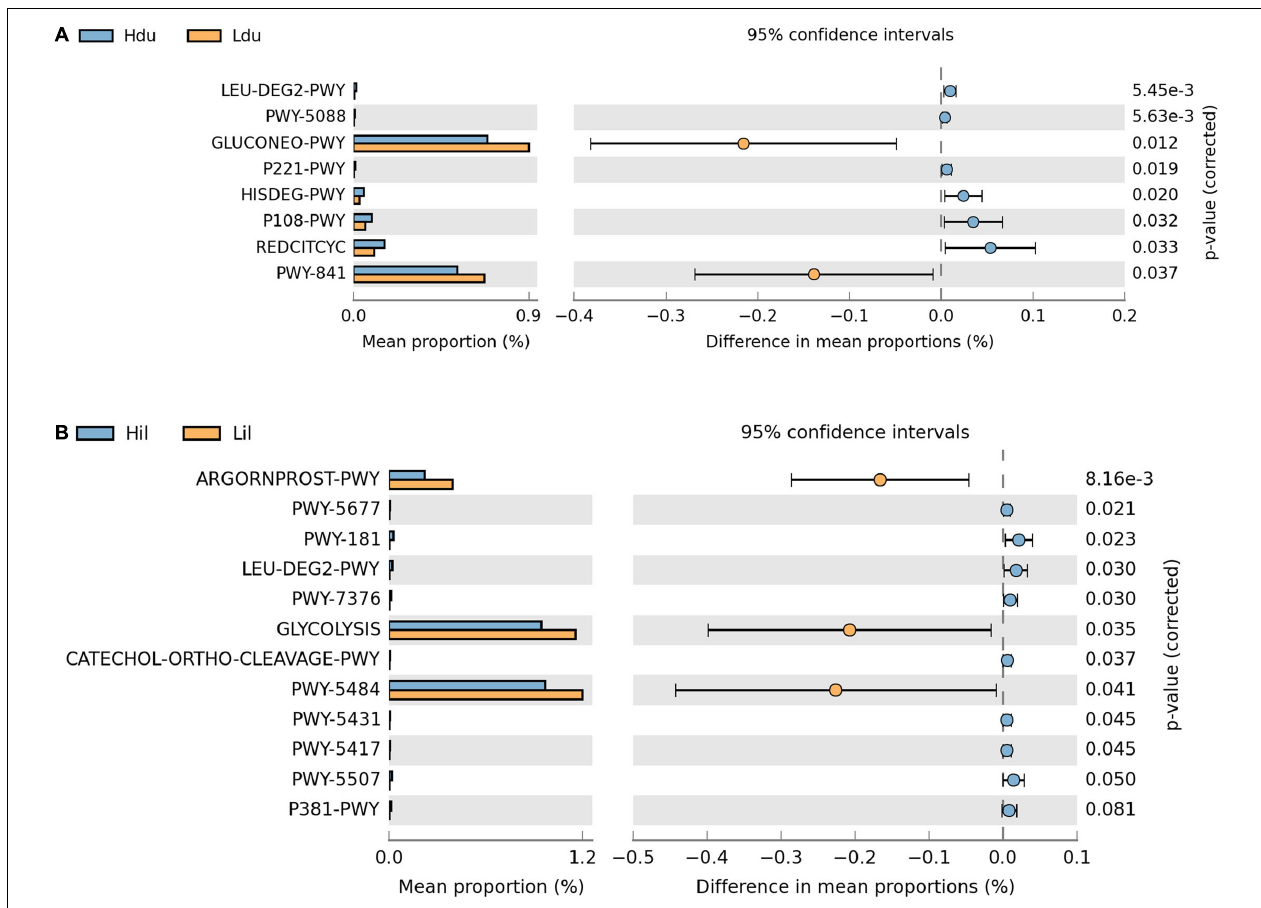
FIGURE 4 | Microbial function prediction in the duodenum (A) and ileum (B) of HFE and LFE groups. The P- values were displayed on the far right. Hdu and Ldu, duodenum of HFE and LFE groups, respectively; Hil and Lil, ileum of HFE and LFE groups,